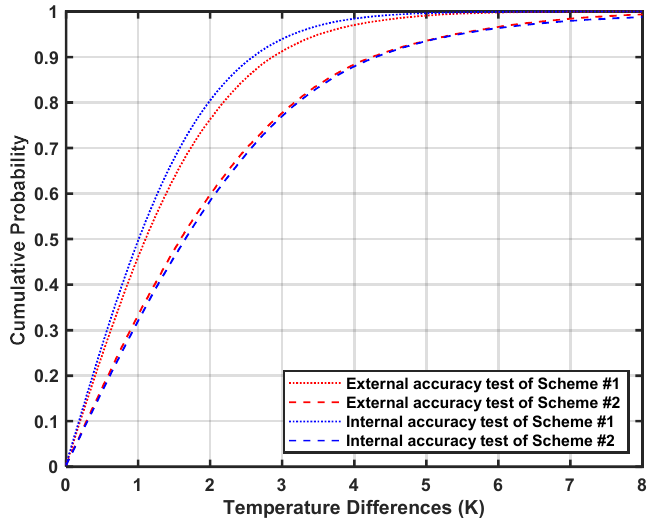
Figure 3. Empirical distribution functions of the temperature differences for the two schemes in different tests.